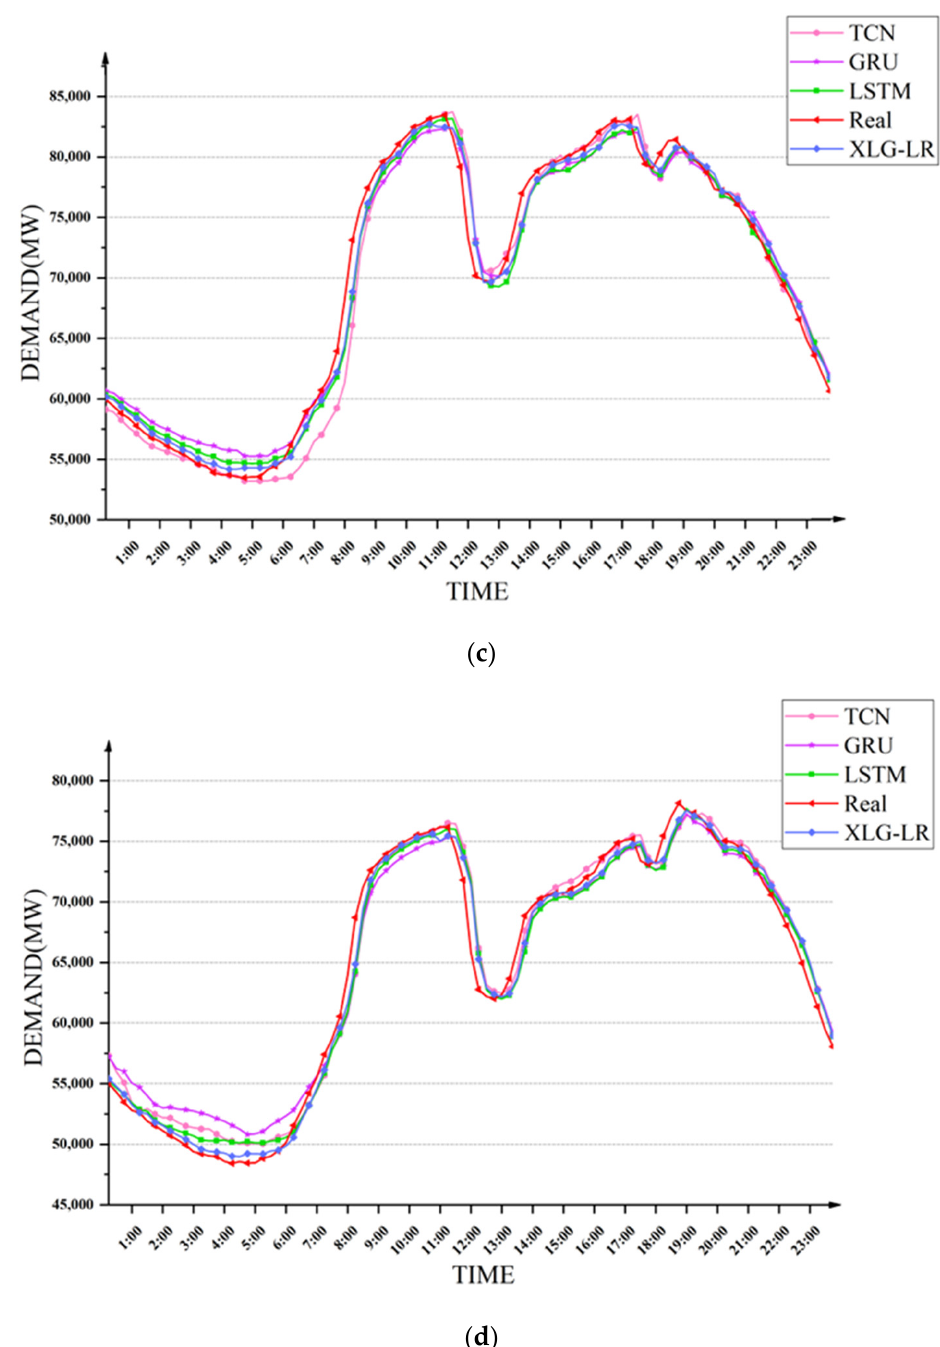
Figure 10. Comparison of Four-season Power Demand Forecasting of Different Models. ( a ) spring; ( b ) summer; ( c ) autumn; ( d ) winter.